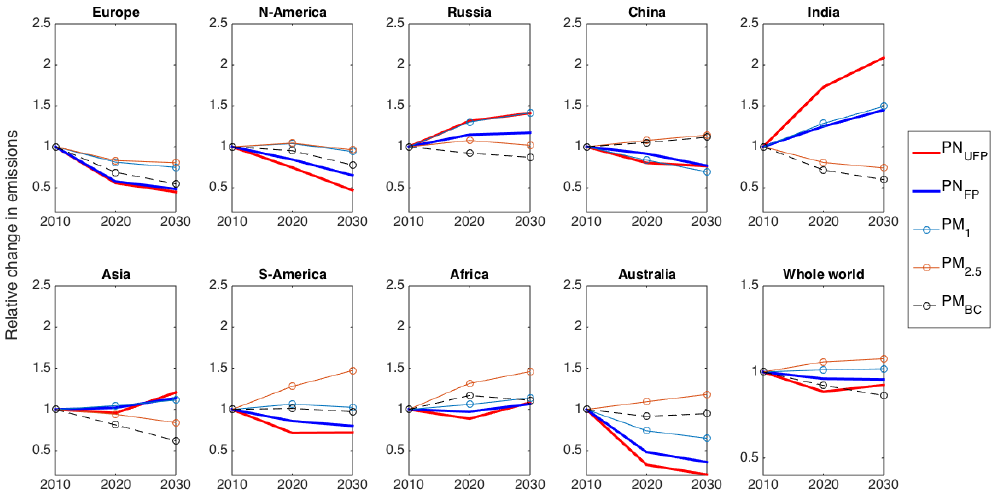
Figure 9. Continental future trends of particle number and mass emissions under current legislation scenario. Emissions are normalized to unity in 2010. Note the different y axis scale in the subplot for the whole